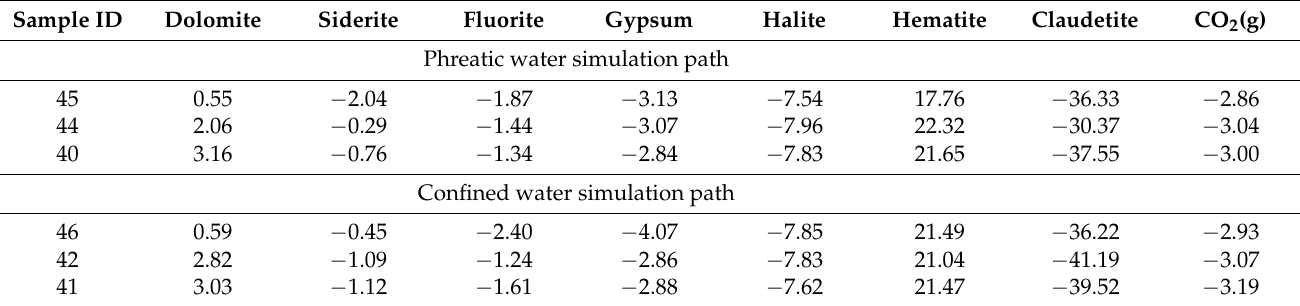
Table 6. Major mineral saturation indices along the simulated path.